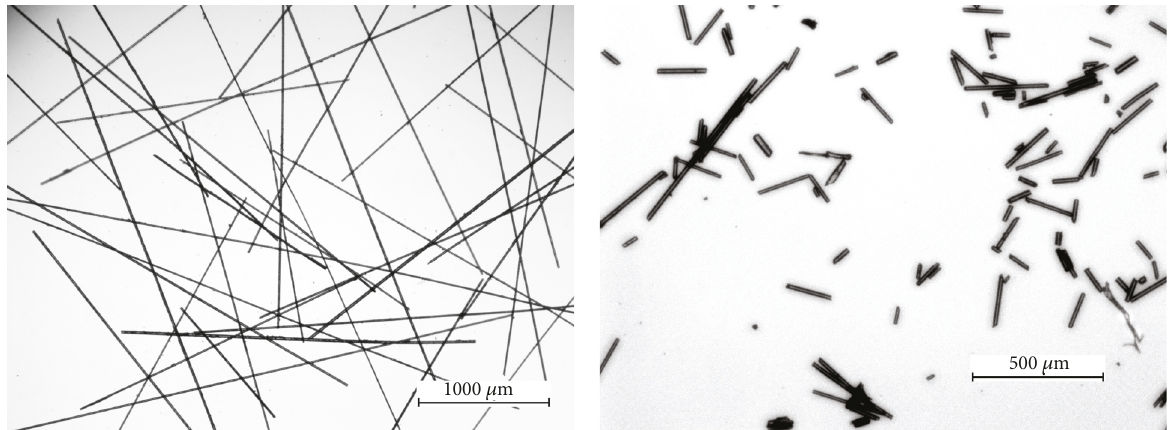
Figure 1: An image of GFCD, before processing (left), after processing (right), optical microscopy, and transmitted light